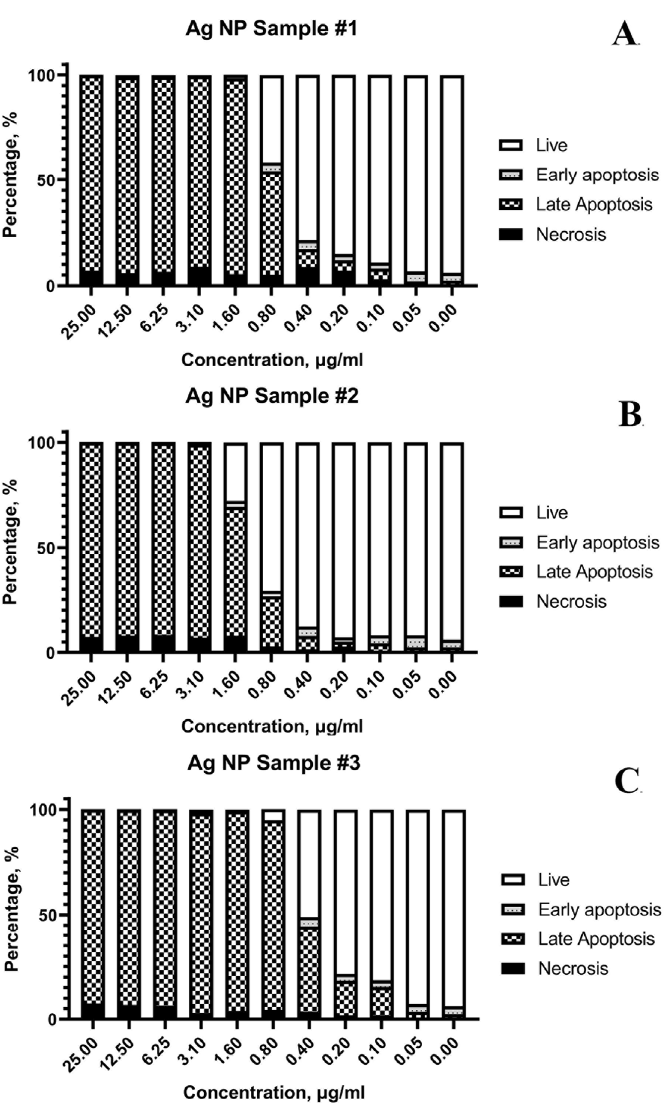
Figure 8. Distribution of Jurkat (T-lymphoblastic leukemia) cells by flow cytometry according to the variants of cell death after exposure to various AgNPs samples: ( A )—sample #1; ( B )—sample #2; ( C )—sample #3.